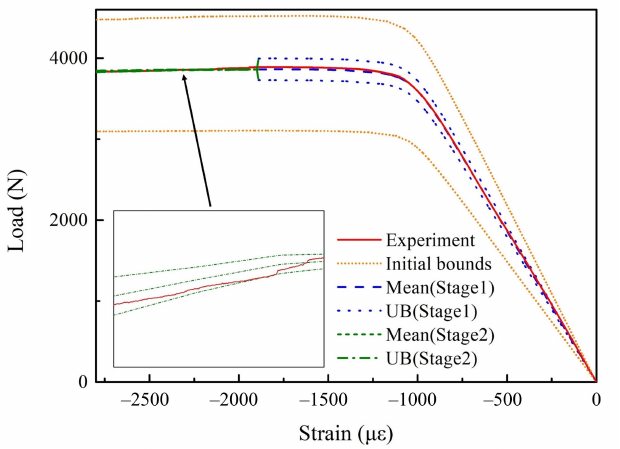
Figure 14. Comparison of load–strain curves between results of the 1st identification and experiment.